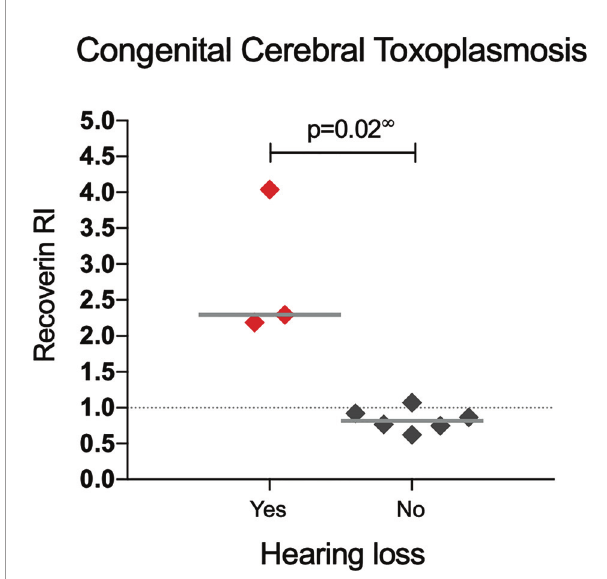
FIGURE 5 | Response to recoverin in patients with congenital cerebral toxoplasmosis without OT. ∞ Mann-Whitney U